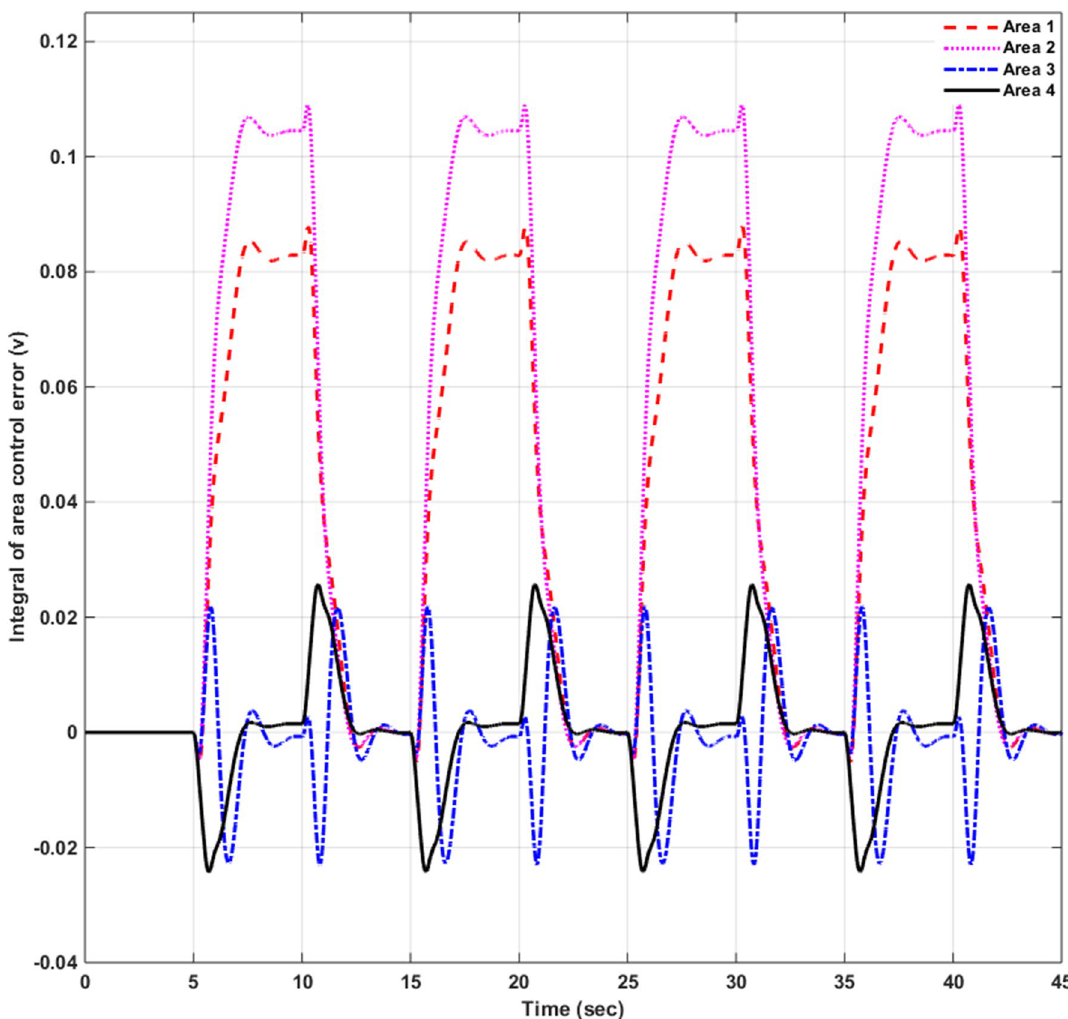
Figure 10. The integral of Area control errors for OQAGC with disturbances.